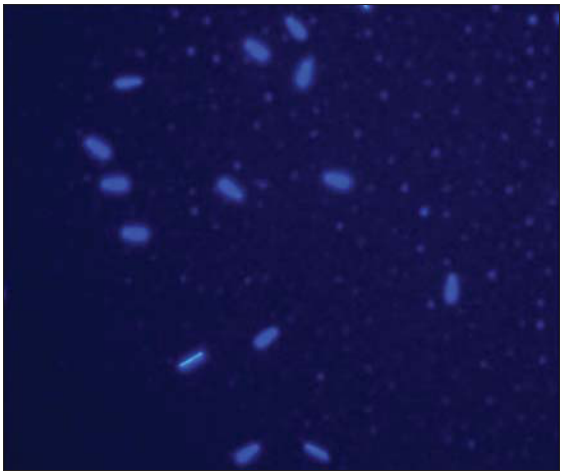
Figure-2: Sperm nucleus stained with DAPI